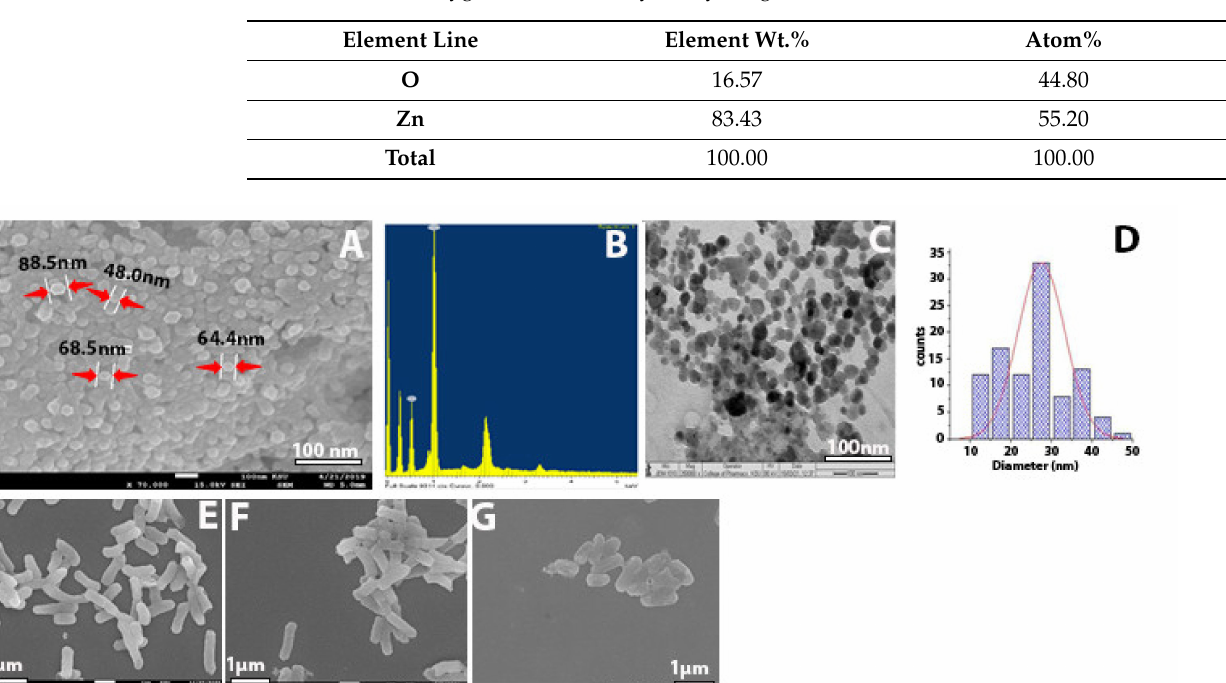
Table 1. Zinc and oxygen elements analyzed by weight % and atom %.